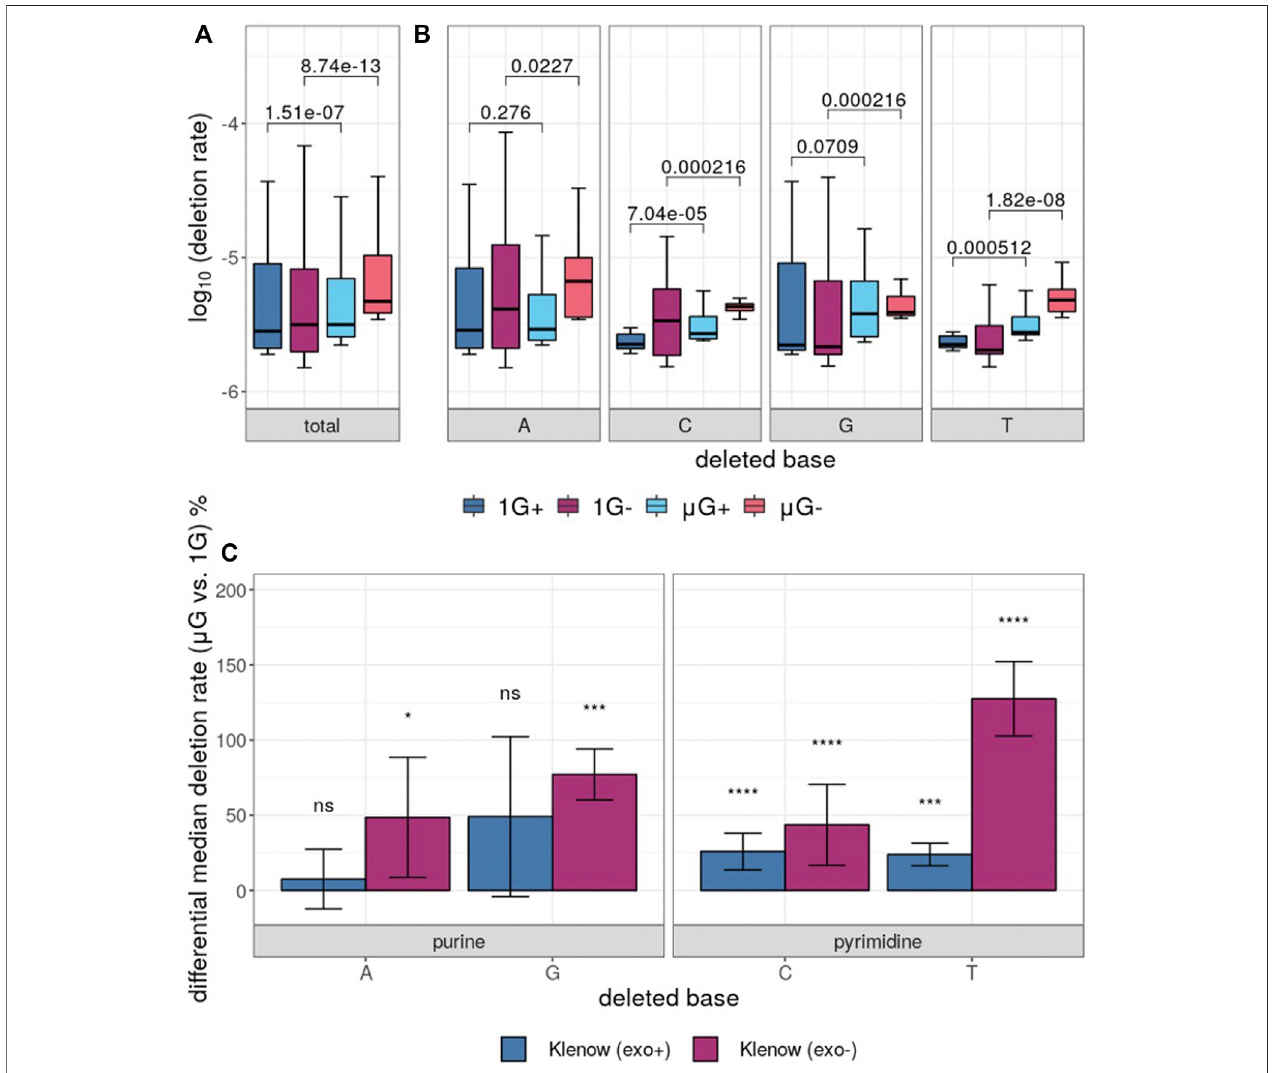
FIGURE 6 | Base deletion error rates in either earth-like gravity (1G) or microgravity ( μ G) from Klenow fragment polymerase polymerization with (+) or without ( − ) exonuclease activity. Mann-Whitney U test p -value symbols are shown plotted for all comparisons, while signi fi cance symbols are shown for signi fi cant comparison only ( p < 0.05 (cid:1) *, p < 0.01 (cid:1) **, p < 0.001 (cid:1) ***, p < 0.0001 (cid:1) ****). (A) Boxplots showing the overall deletion error rate (log 10 ) for each test condition and colored according to Figure 3 . (B) Deletion error rate for each test condition grouped by deleted base, with the boxes colored as indicated. (C) Differential percentage deletion error rate for each base, separated by purine versus pyrimidine bases. Bar-plot error bars in (b) and (c) represent the standard deviation of each group.